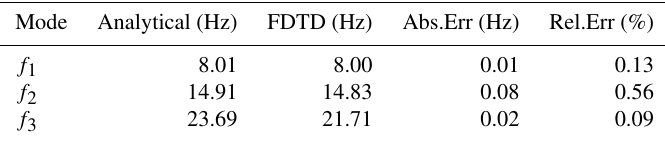
Table 2. Comparison of resonance frequencies obtained analytically and numerically for a spherical waveguide with a conducting layer above